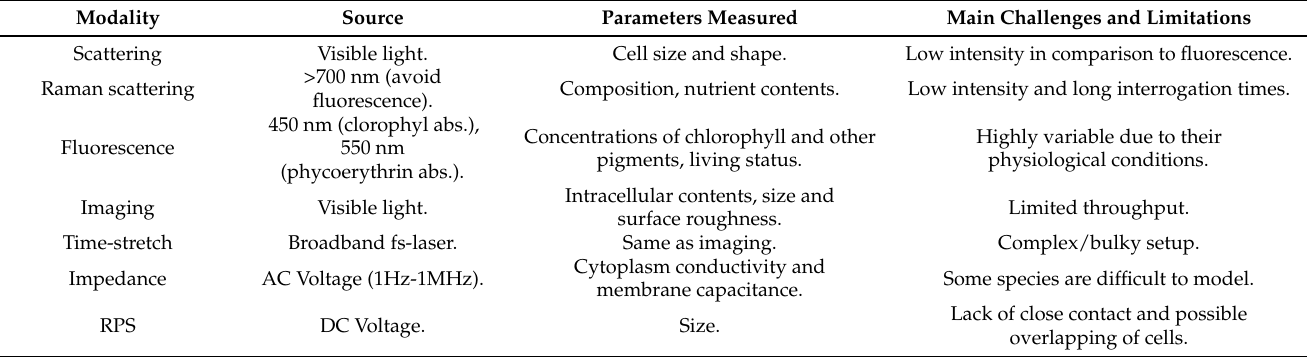
Table 1. Comparative table of different microfluidic technologies for phytoplankton